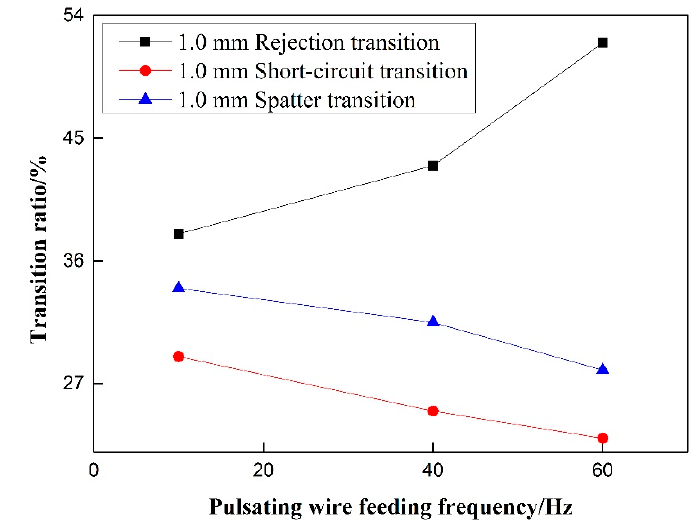
Figure 15. E ff ect of pulsating wire feeding frequency on transition ratio under 1.0 mm withdrawal quantity.